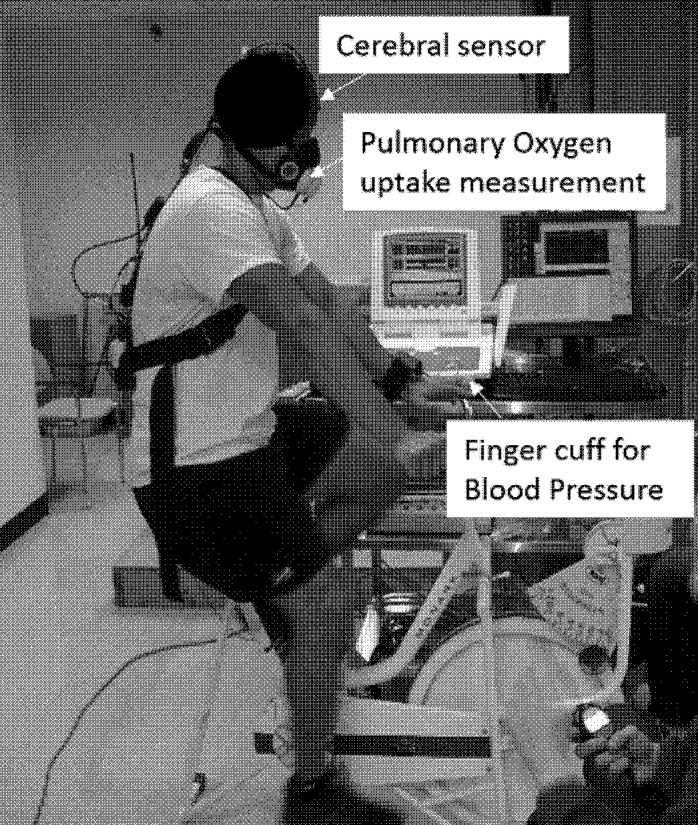
Experimental setup for the participant.